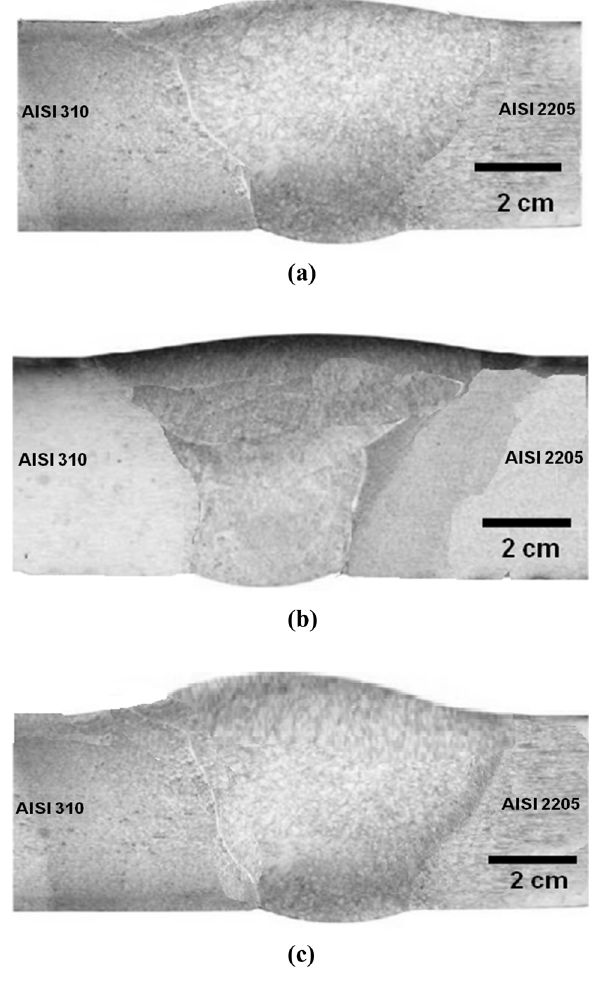
Figure 2: Cross - section of ( a ) W - A, ( b ) W - 3C, and ( c ) W -